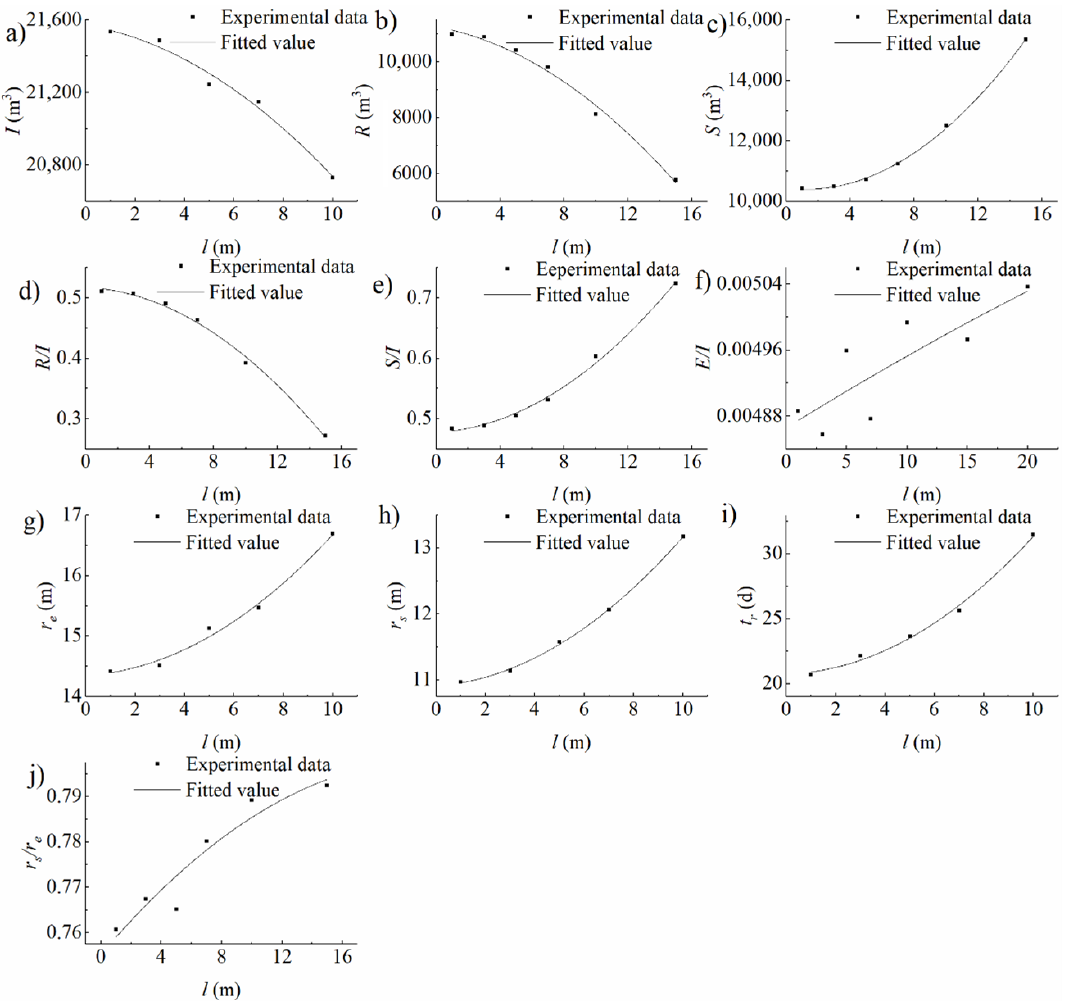
Figure 10. The variations with an increment in l when the depth is 20 m. (( a ) variation of I; ( b ) variation of R; ( c ) variation of S; ( d ) variation of R/I; ( e ) variation of S/I; ( f ) variation of E/I; ( g ) variation of r e ; ( h ) variation of r s ; ( i ) variation of t r ; ( j ) variation of r s /r e .).